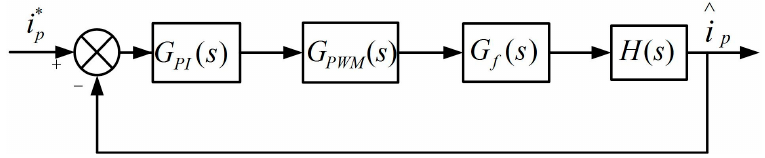
Figure 6. Control structure of active current in DC/AC converter.